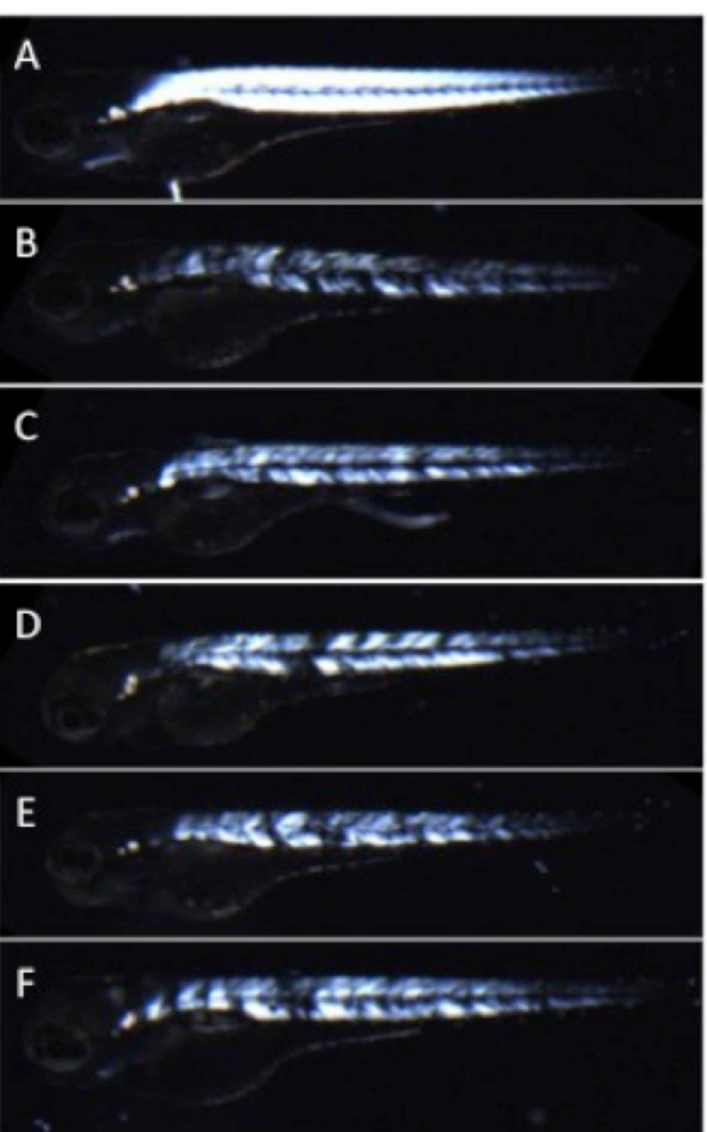
Fig 2. Muscle fiber detachment of caf mutants can be observed with birefringence. Under plane polarizedlight, muscle from WT siblings(A) appearsuniformly bright and white, consistent with normal muscle organization. In contrast, Caf mutants (B-F_ can be identifiedas havingstochastic patterns of muscle degeneration and detachmentwith birefringence as early as 2 dpf. This is seen in the muscle compartment as dim white areas (thinnedor atrophiedfibers) and black spots (presumedareas of muscle fiber detachment). Of note, genotypefor all depictedanimalswas confirmed by Sangersequencing. Bars representmean ±